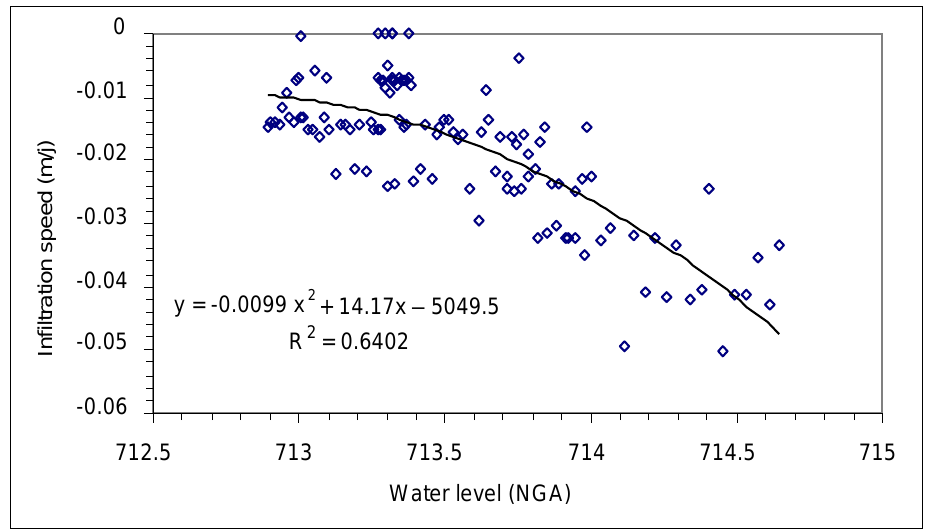
Figure 40. Variation of the infiltration speed depending on the water level of the lake at Hammam-Grouz dam,